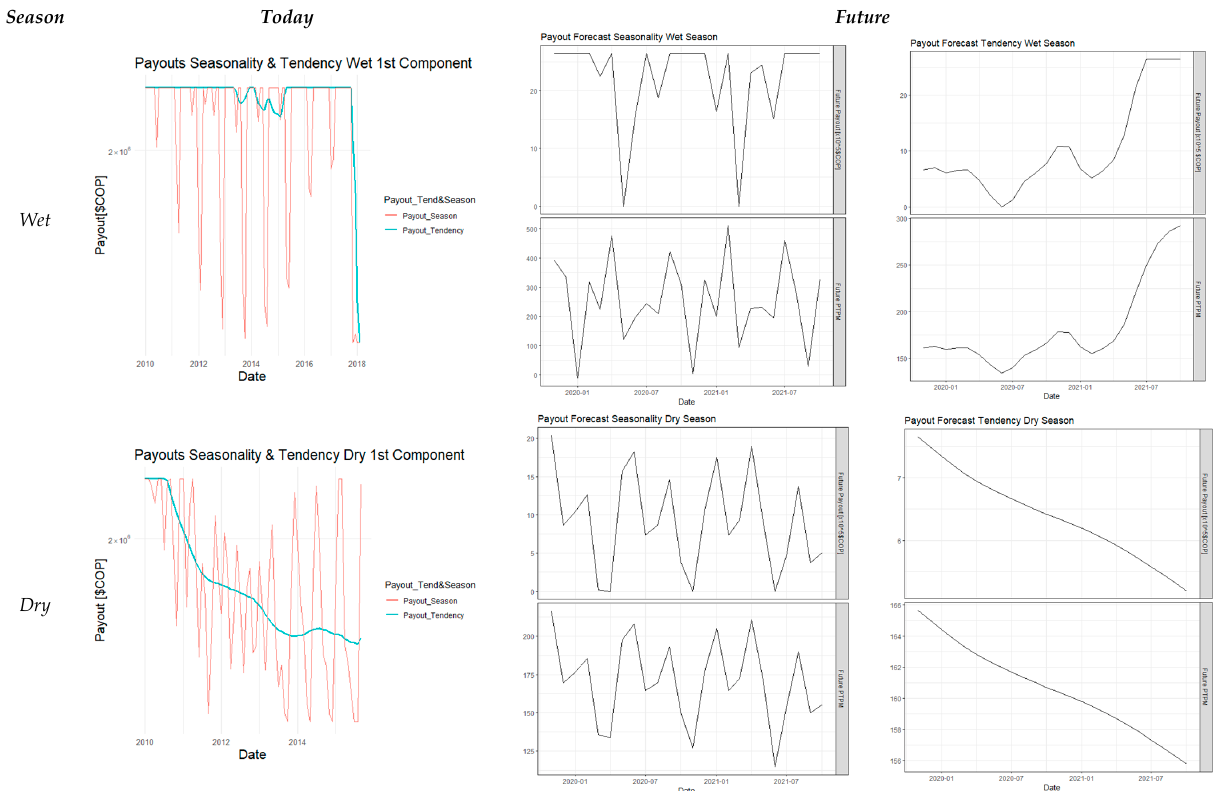
Figure 9. Decomposition of POs for seasonality and tendency in wet and dry months. Source: author’s processing. Table 7. Future payouts in exceedance (PoEs) and ratios (POERs) for 2 years ahead. Note: arrows reflect the direction of the tendency. Source: author’s